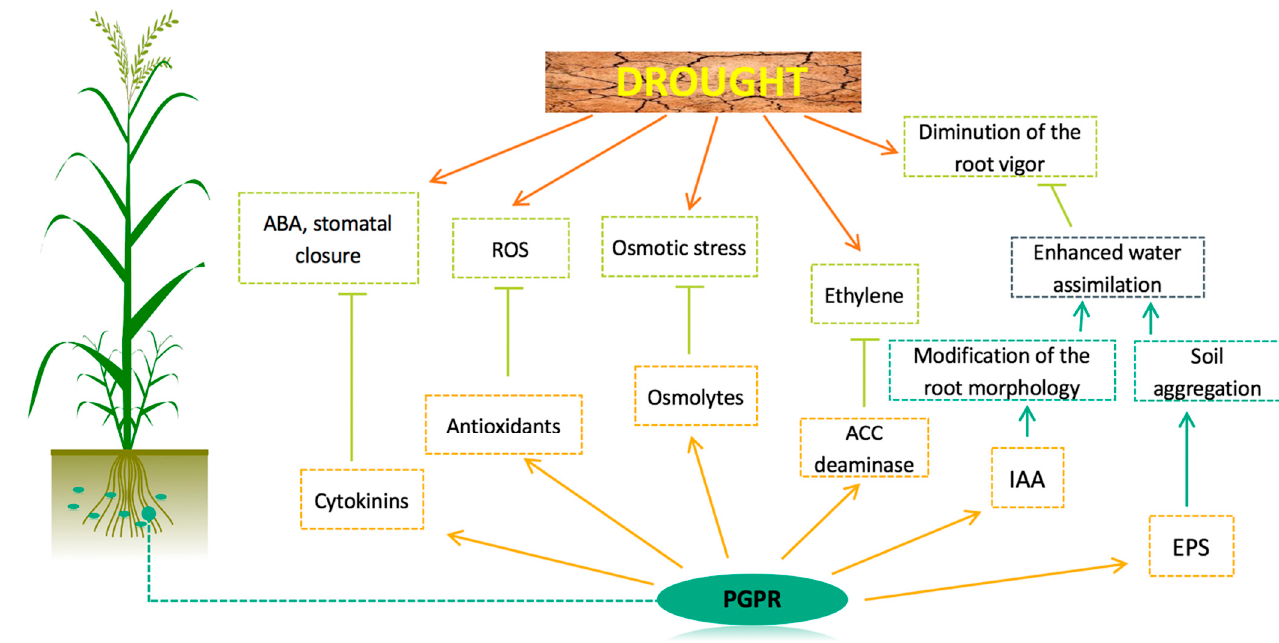
Figure 4. Wheat drought acclimation by PGPRs (inspired from Kaushal and Wani, 2016b). ROS: reactive oxygen species; ACC: 1-aminocyclopropane-1-carboxylate; IAA: indole acetic acid; EPS: exopolysaccharide.